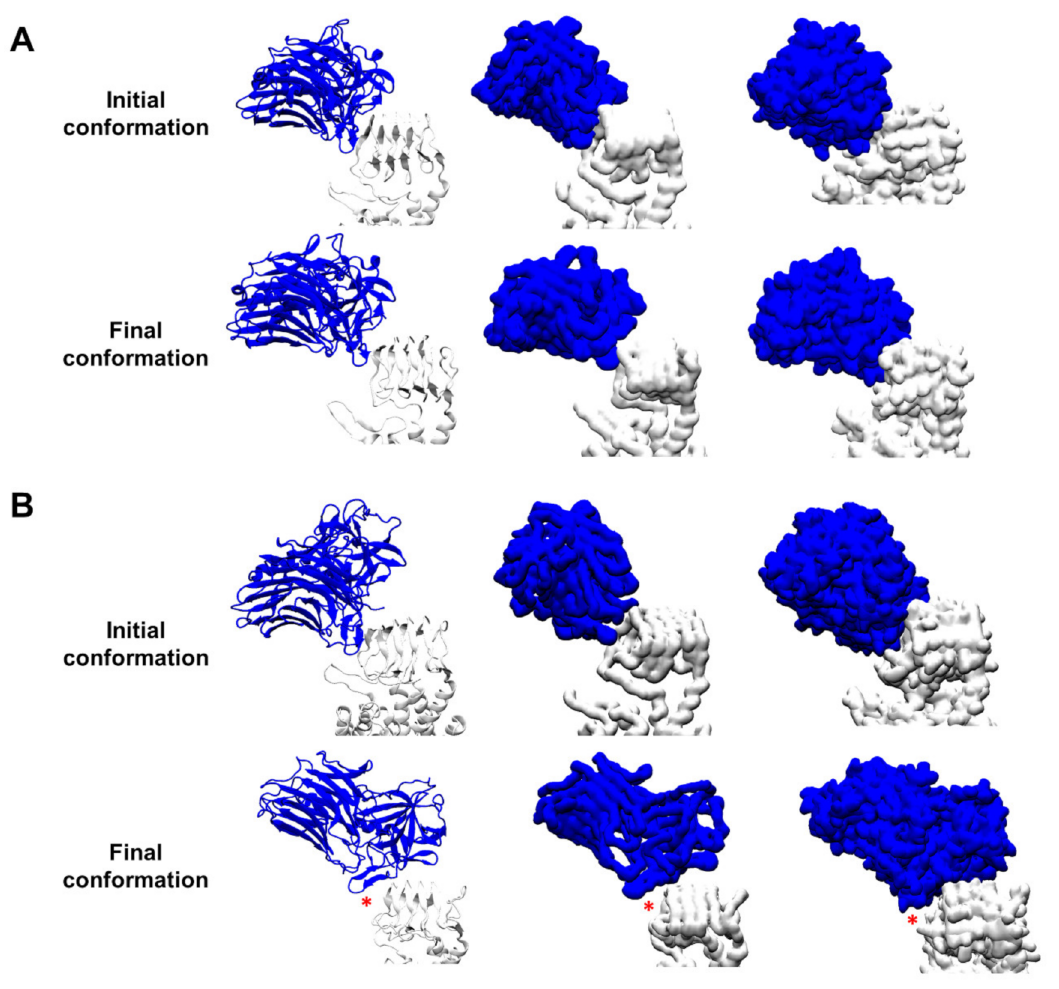
Figure 2. Evolution of the BoNT/A1–hSV2Ag and BoNT/F1–hSV2Ag complexes via MDS. Snapshots showing the initial and final conformations of the BoNT/A1–hSV2Ag complex ( A ) and the initial and final conformations of the BoNT/F1–hSV2Ag complex ( B ). BoNT/A1 and F1 are depicted as the color blue while hSV2Ag is represented as the color white. The left column shows an illustrated representation of the complexes. The middle column shows surface representation of the complexes that considers only the atoms of the backbone. The right column shows a surface representation of the complexes that considers all atoms (backbone and side chains). Red asterisks highlight a gap showing that there is no intermolecular contact between the toxin and the protein part of